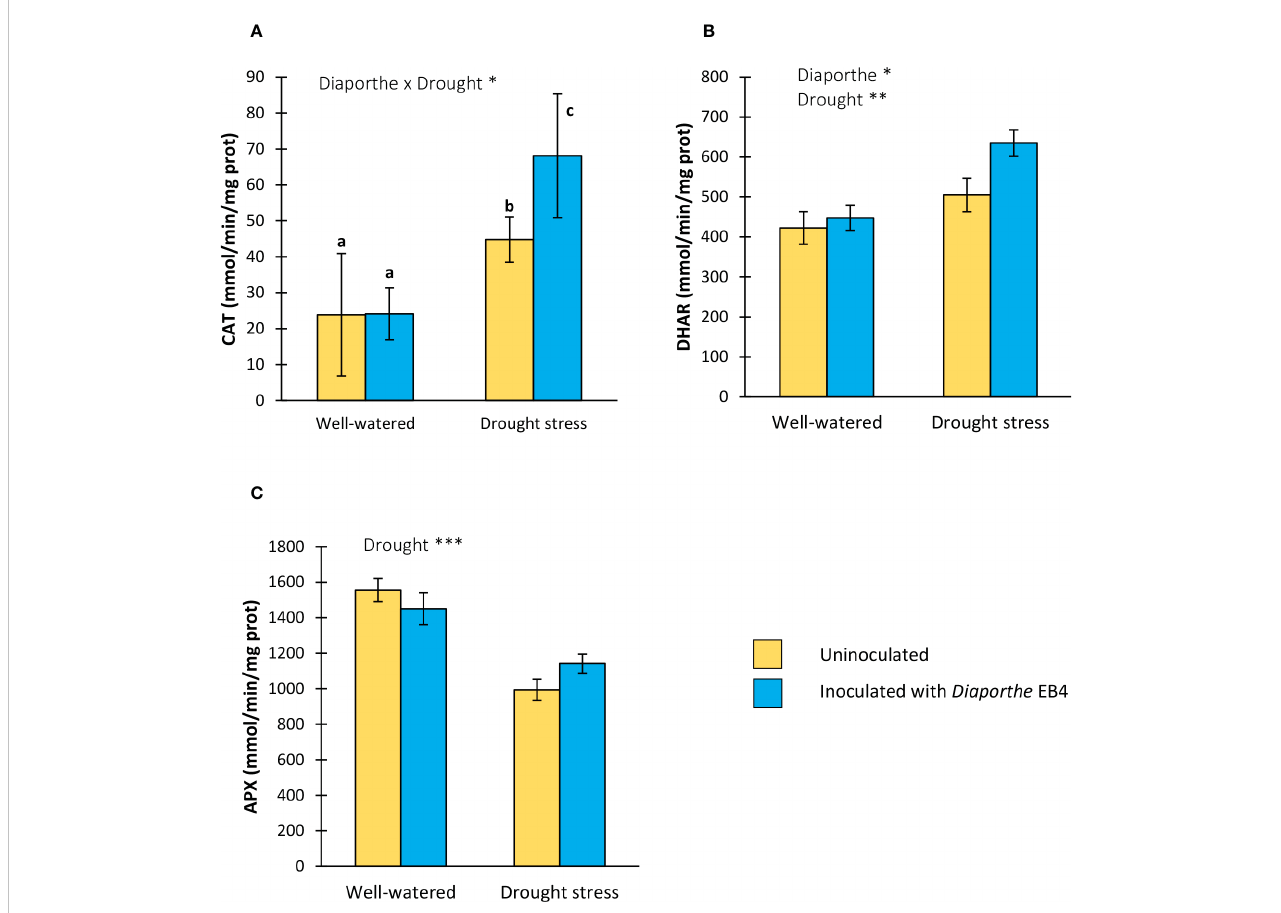
FIGURE 4 Activity of the antioxidant enzymes (A) catalase (CAT), (B) dehydroascorbate reductase (DHAR), and (C) ascorbate peroxidase (APX) of tomato plants uninoculated (yellow) or inoculated with Diaporthe EB4 (blue), with two different water treatments (well-watered or drought stress). Different letters indicate different means (Tukey p < 0.05) for the [ Diaporthe inoculation × Drought] interaction. Values are means +SE (n=5). Level of signi fi cance: * p <0.05; ** p <0.01; *** p <0.001.